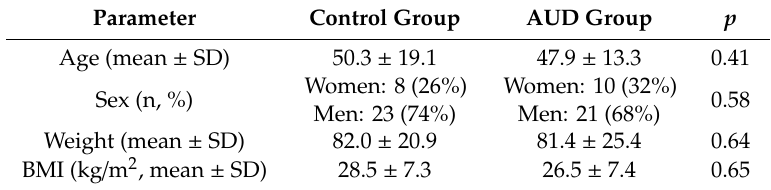
Table 3. Demographiccharacteristicsofanalyzedsubjects. AUD = alcoholusedisorder,SD =